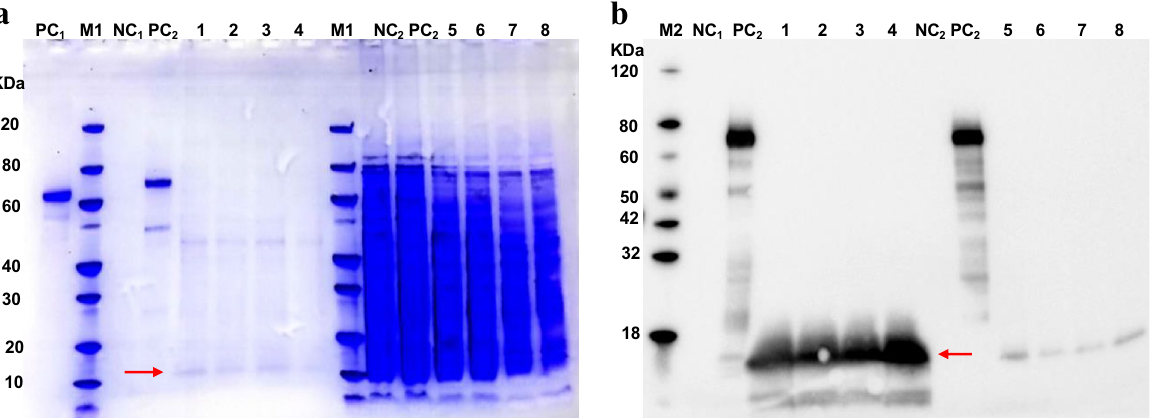
Figure 6. Sodium dodecyl sulphate–polyacrylamide gel electrophoresis (SDS-PAGE) and western blotting results of the induced products. ( a ) SDS-PAGE analysis of pPIC9K-hirudin expression in recombinant Pichia pastoris . ( b ) Western blot analysis of recombinant hirudin. (Lane M1: Protein MW marker (Broad); Lane M2: protein Marker (GenScript, Cat. No. M00673); Lane PC 1 : bovine serum albumin (1 µg); Lane PC 2 : positive control (GenScript, Cat. No. M0101); Lane NC 1 : medium without induction; Lane NC 2 : cell pellet without induction. Lane 1: supernatants from GS115/pPIC9K-hirudin after 24 h induction; Lane 2: Supernatants from GS115/pPIC9K-hirudin after 48 h induction; Lanes 3, 4: Supernatants from GS115/pPIC9K-hirudin after 72 h induction; Lane 5: Precipitate from GS115/pPIC9K-hirudin after 24 h induction; Lane 6: Precipitate from GS115/pPIC9K-hirudin after 48 h induction; Lanes 7, 8: Precipitate from GS115/pPIC9K-hirudin after 72 h induction.) The target protein is indicated using a red arrow (~ 15 kDa). Recombinant hirudin was analyzed on a 15% SDS-PAGE gel. The original gel is presented in Fig.